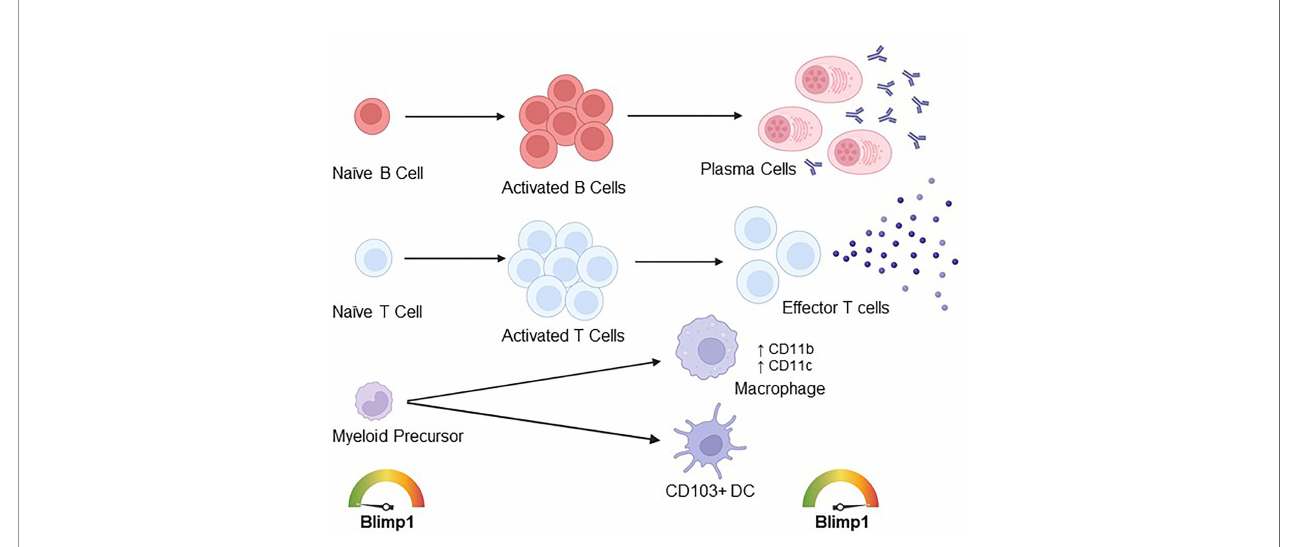
FIGURE 3 | Described roles of Blimp1 in immune cell effector differentiation and function. Blimp1 expression in naïve B cells is low, however, during activation Blimp1 is upregulated and necessary for the differentiation of antibody-secreting plasma cells. Similarly, Blimp1 is lowly expressed in naïve T cells and upregulated during T cell activation, with higher expression in effector T cells. Further, Blimp1 plays important roles in effector T cell function, suppressing the differentiation of T FH cells and regulating the expression of several cytokines (including Il2 , Il17, Il10, Ifn) , chemokines and cytokine/chemokine receptors ( including Ccl8, Il-23r, Cxcr5, Il2ra, Ccr7) and surface molecule ( including PD-1 and Ctla4) genes. In dendritic cells (DCs), Blimp1 restrains autoantibody production by mitigating IL-6 production and antigen presentation on MHCII, and Blimp1 plays a role in the differentiation of CD103 + intestinal DCs. Blimp1 is also upregulated during macrophage differentiation, and Blimp1 overexpression in vitro is suf fi cient to drive macrophage